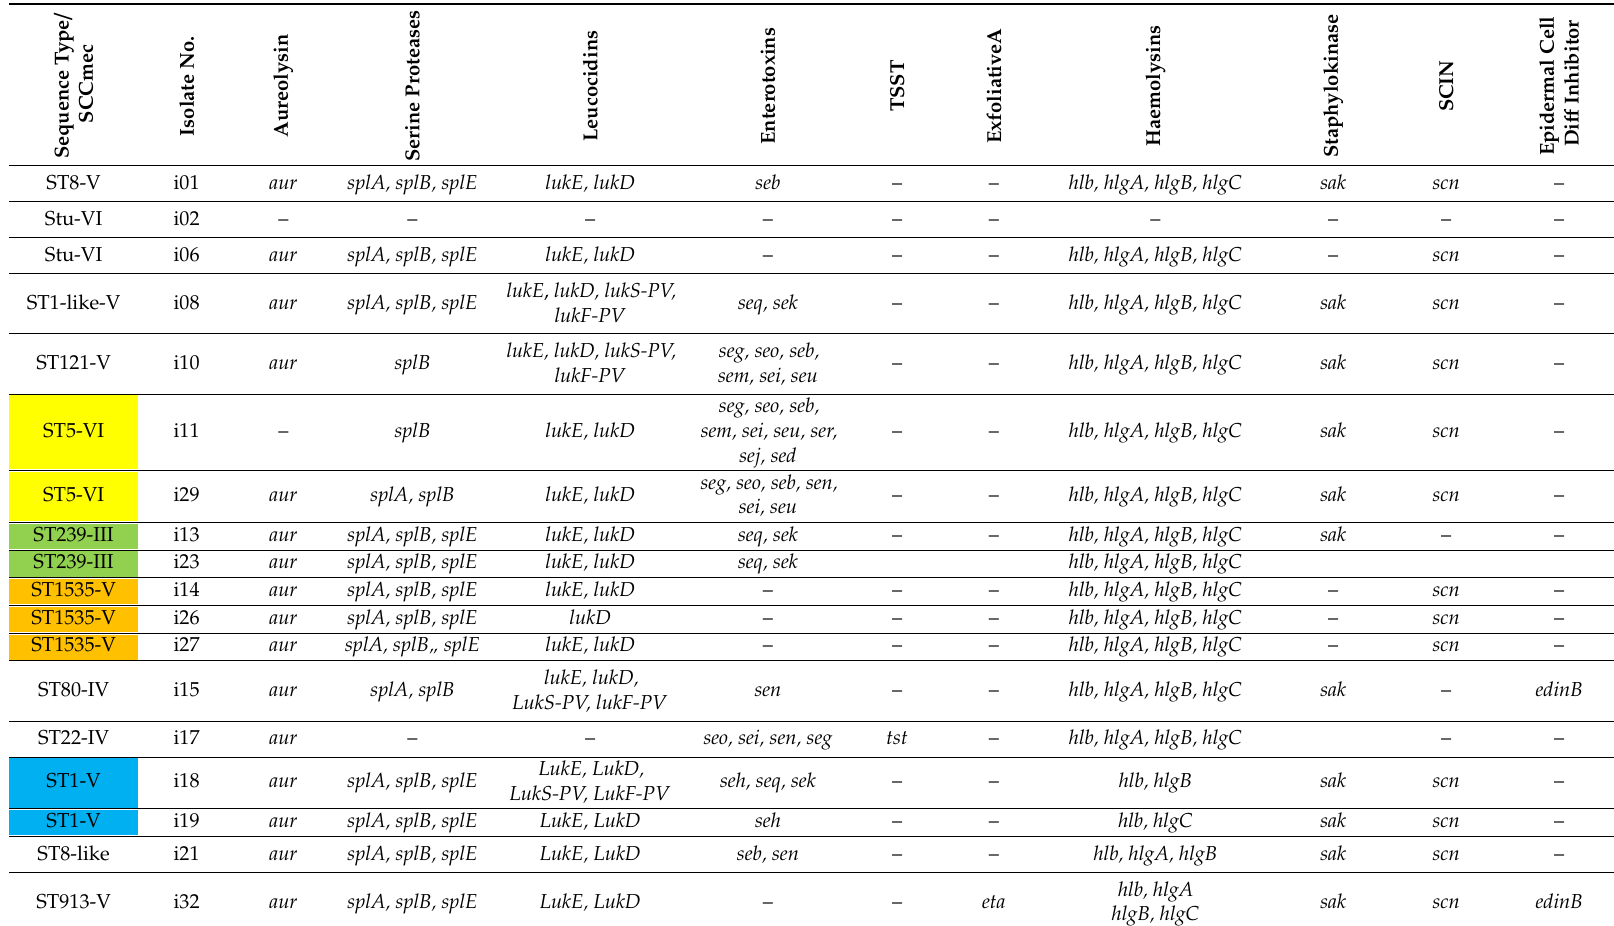
Table 3. Virulome of the sequenced MRSA